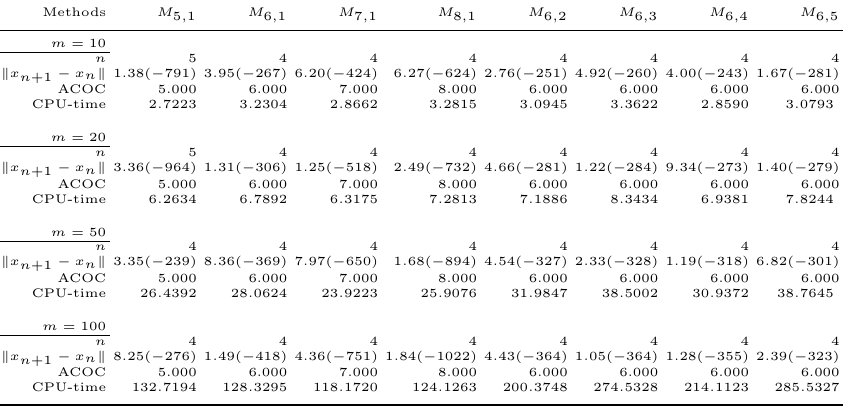
Table 4. Comparison of performance of methods for Problem 1 Methods